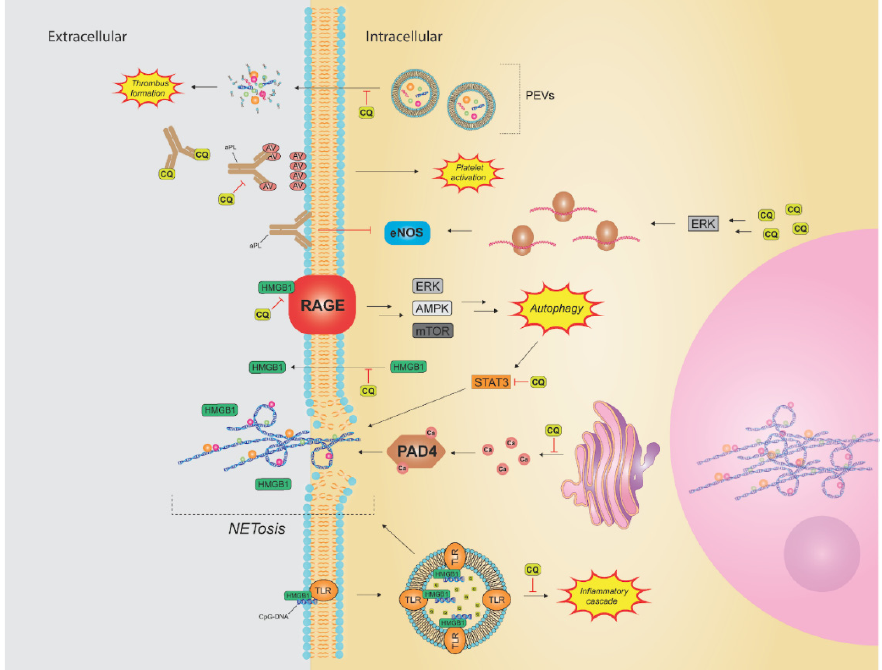
Figure 3. The impact of chloroquine and hydroxychloroquine on endosomal and lysosomal function. ( A ) Endosomal internalization of ligands allows for cell signaling. This process requires an acidic environment which CQ inhibits, preventing downstream signaling through endocytic TLRs and the NOX complex. ( B ) CQ induces lysosomal membrane permeabilization, leading to cell death. ( C ) CQ prevents lysosomes from merging with autophagosomes in the process of autophagy through lysosomal alkalinization.